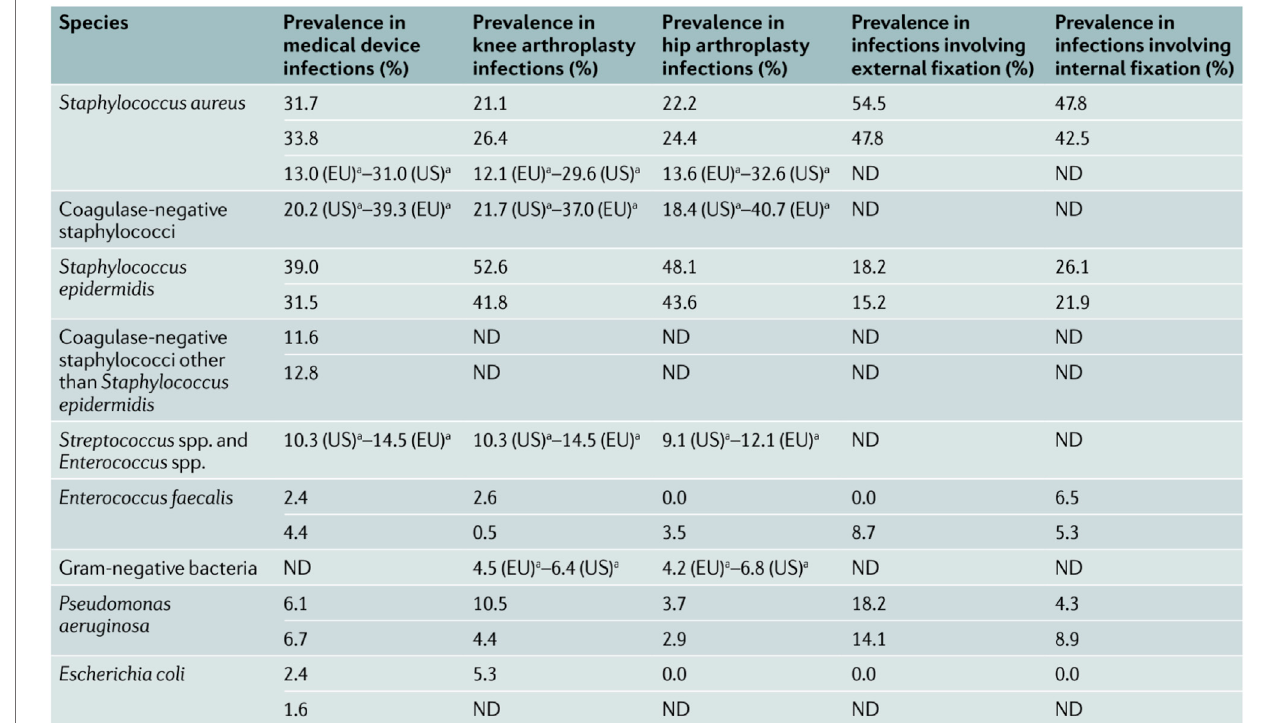
Frontiers in Bioengineering and Biotechnology |